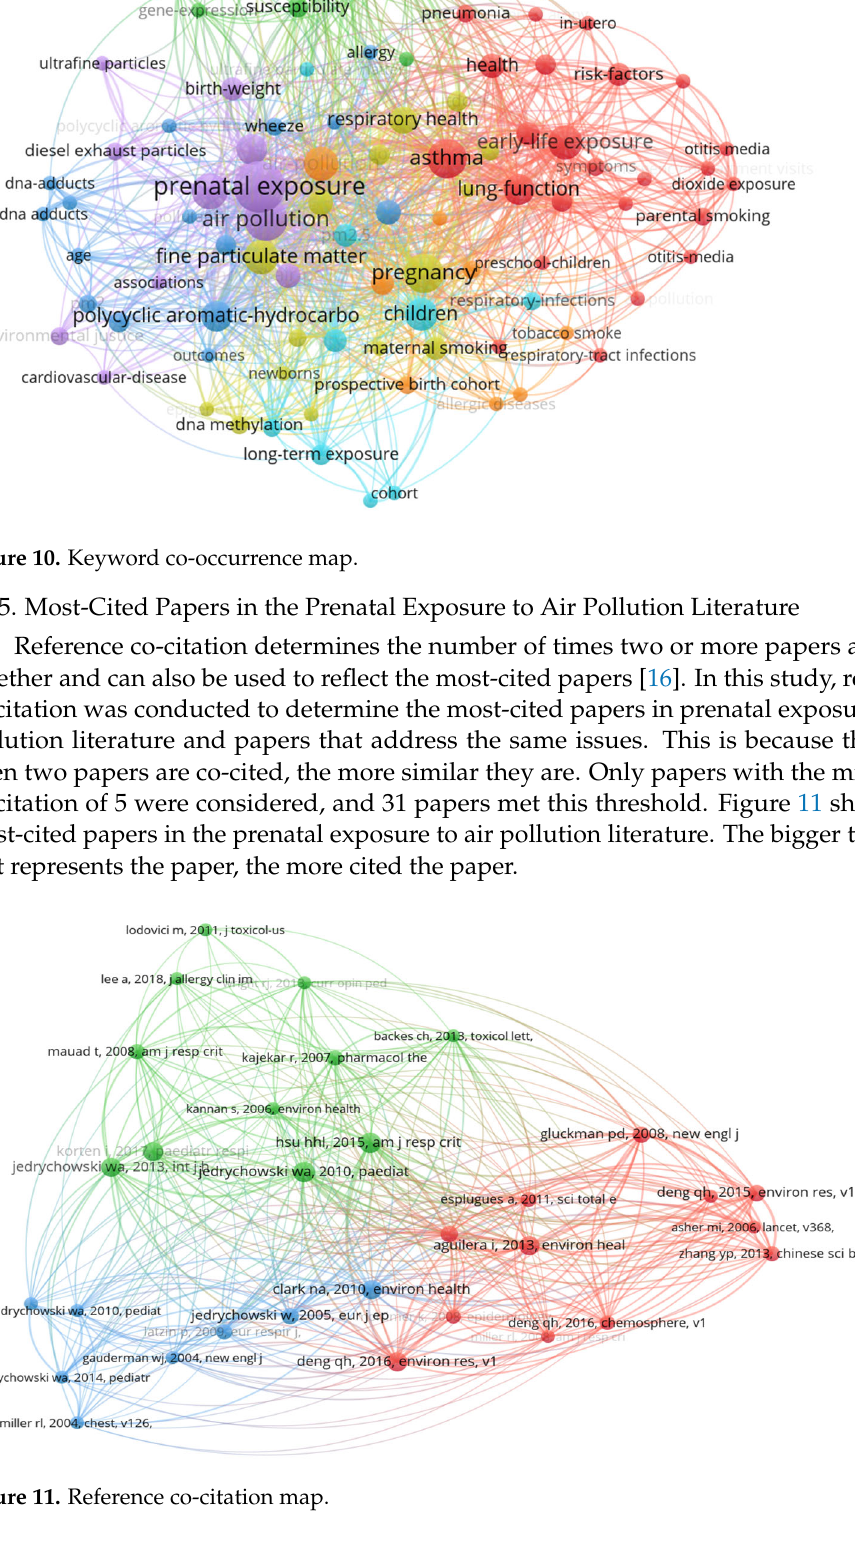
Table 2. Top 14 keywords with the highest frequency in prenatal exposure to air pollution literature.